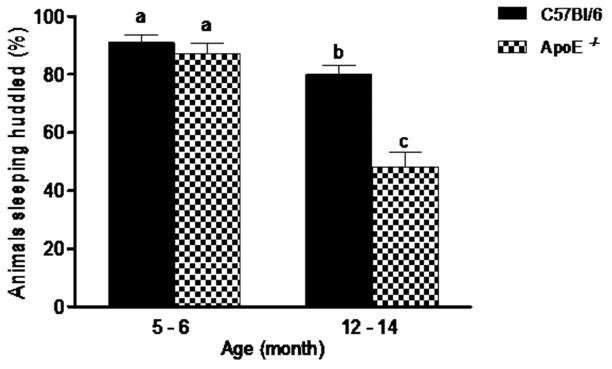
Figure 1. Percent of aged ApoE − / − mice sleeping huddled in the same quadrant decreased significantly in relation to young animals while no differences were detected in C57Bl/6 mice. Sleeping pattern of C57Bl/6 and ApoE − / − mice with different age and sex (n=10/sex/age/genotype) was evaluated twice daily over 5 consecutive days. Values are expressed as combined male and female data means ± SEM. Different letters (a,b,c) represent signi fi cant differences between groups (F(3/39)= 27.15, p =0.000). Kruskal Wallis non-parametric one-way ANOVA and Tukey’s Multiple Comparison Tests. No differences were observed between sexes in both strains.